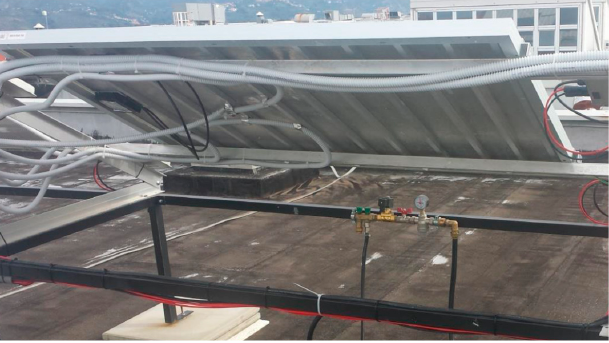
Figure 2. Thin metallic plate installed on the module PV4 for temperature uniformity.